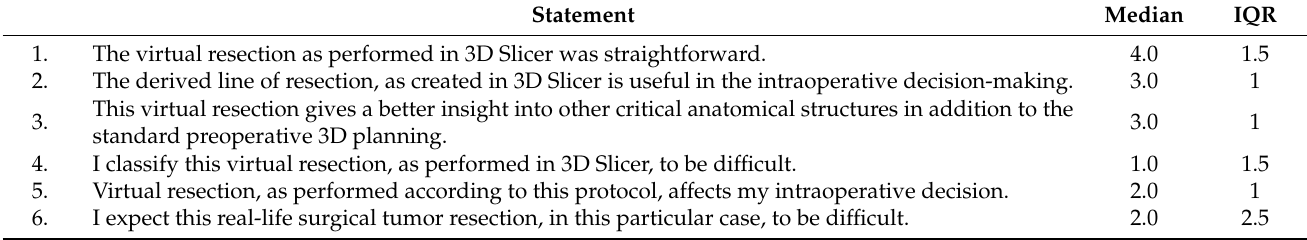
Table 3. Results of the questionnaire were filled in by each surgeon. The results represent the patient cumulative opinion per statement. The table visualizes both the opinion per clinician in addition to the median